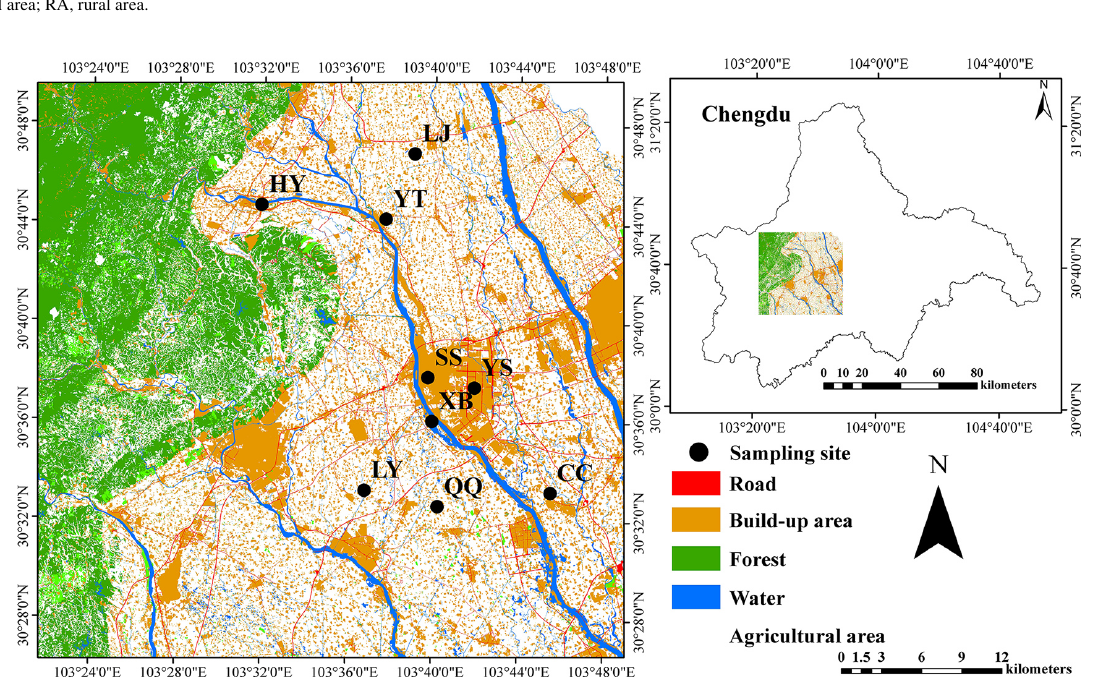
Figure 1. Location of the sampling sites. SS, Shangnan Street; YS, Yongkang Street; XB, Xihe Bridge; CC, Caichang; LY, Liaoyuan; QQ, Qiquan; YT, Yuantong; LJ, Liujie; HY, Huaiyuan (Deng et al.,